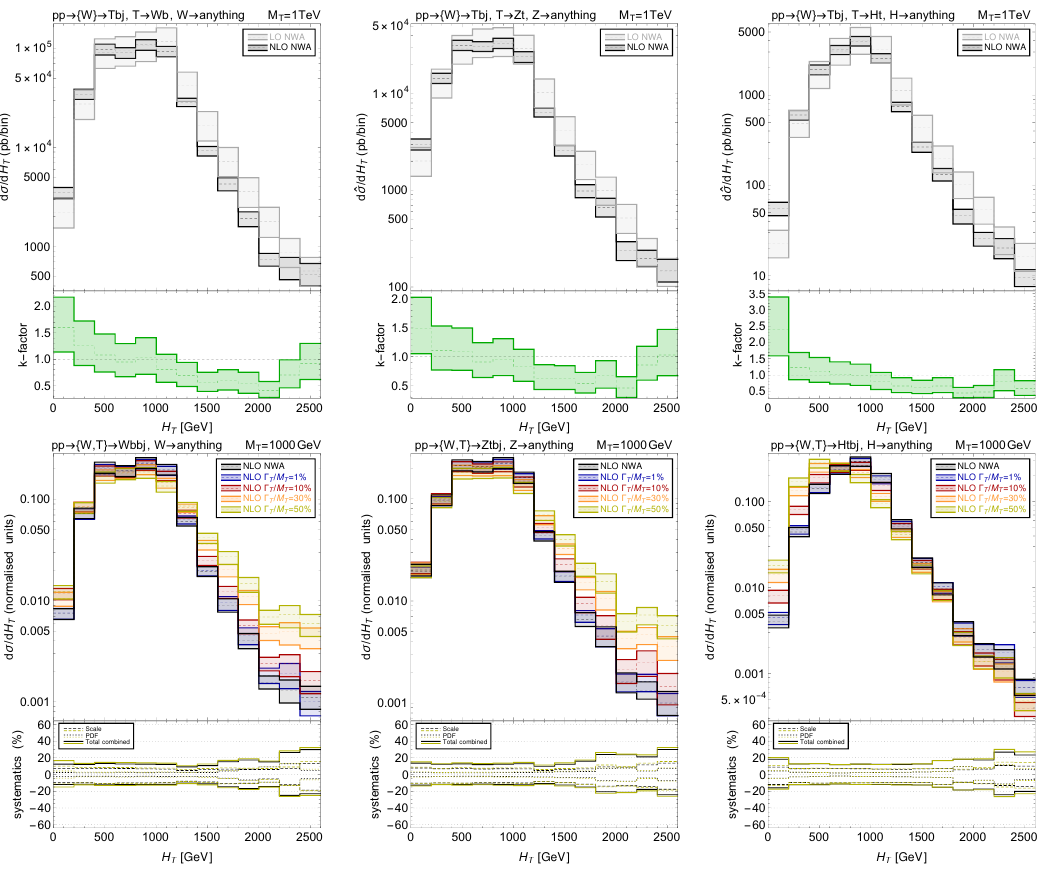
Figure 15 . Same as in figure 13 but for the hadronic activity defined as H T = P